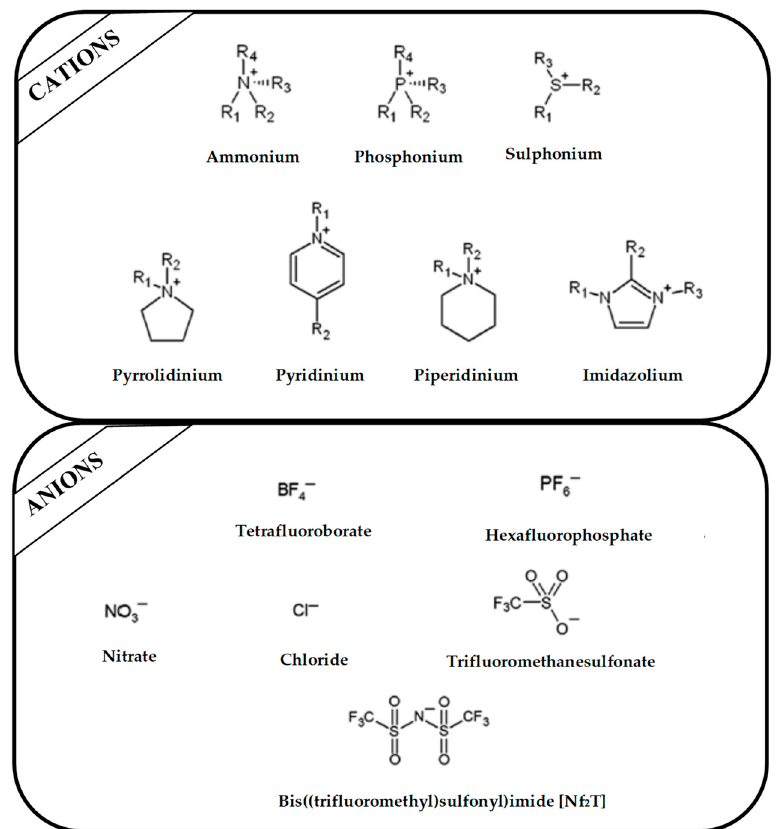
Figure 2. Examples of popular anions and cations of ILs used in analytical methods.